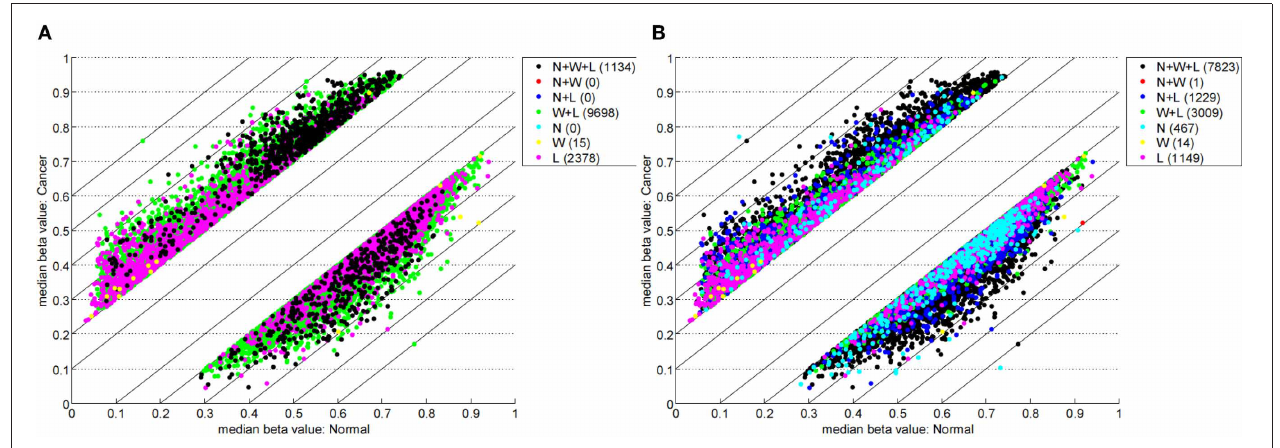
FIGURE 3 | Comparison of methylation levels with post-filter. NIMBL-compare output of median beta values of normal versus cancer samples when no samples ( m = 0) (A) or up to two samples ( m = 2) (B) were